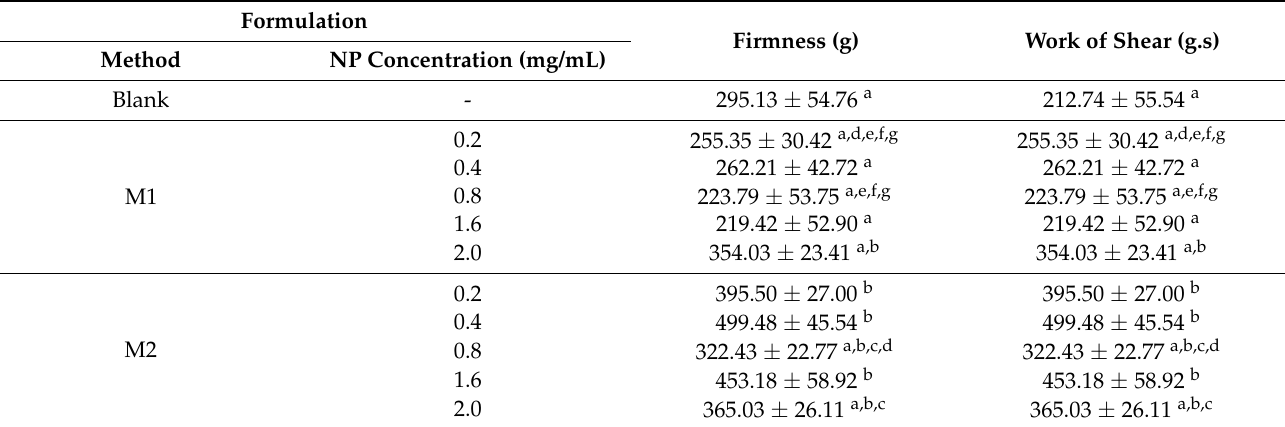
Table 4. Firmness and work of shear of P407 18% Casein 10% hydrogel at different concentrations of the TBH-PCL nanoparticles added before (M1) and after (M2) gel formation.